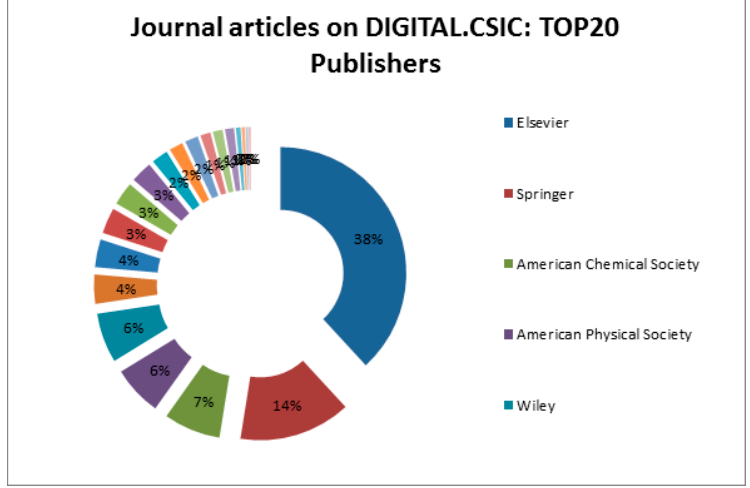
Figure 9. Distribution of CSIC research articles on DIGITAL.CSIC by publisher. Source: DIGITAL.CSIC.